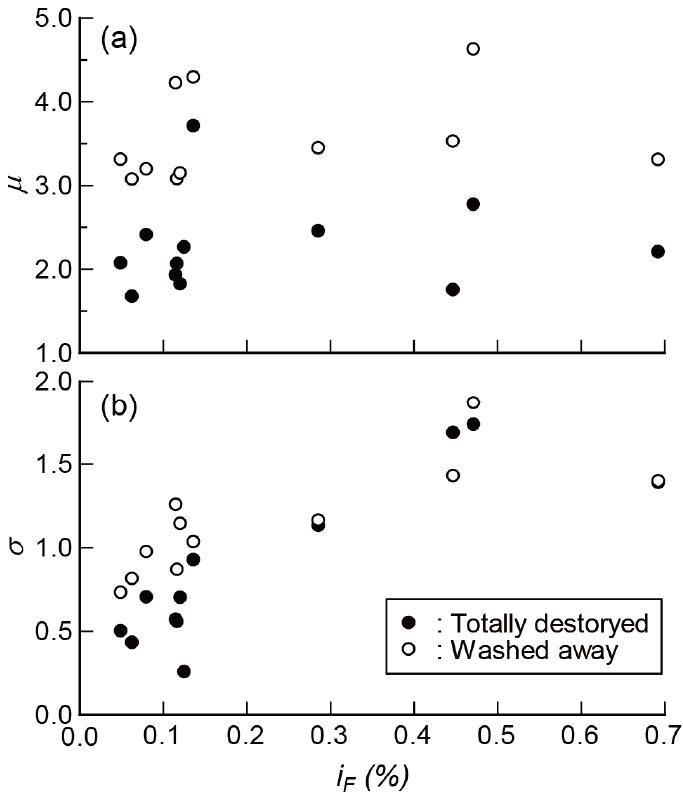
Figure 12. Relationships between i F and coefficients ( a ) μ and ( b ) σ .